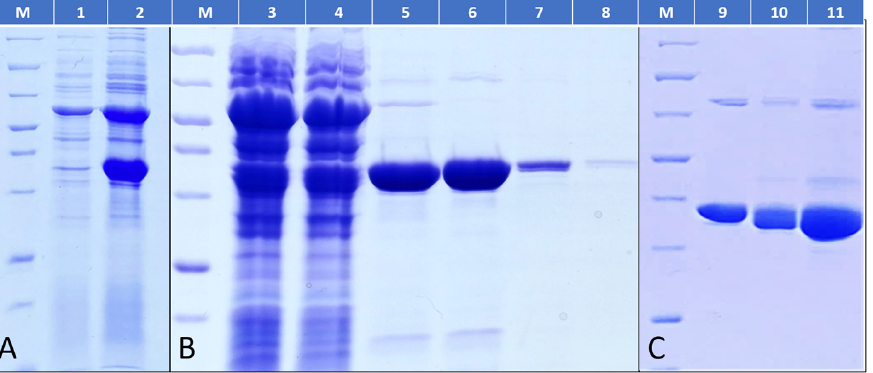
Figure 1. Purification of Tm -MreB using BL21 DE3 Arctic express cell line. ( A ) Molecular weight marker (M) followed by the cell lysates before (lane 1) and after induction with IPTG (lane 2). ( B ) Purification of Tm -MreB using high-salt purification buffers: lane 3: cell lysate before ultracentrifugation; lane 4: supernatant after ultracentrifugation; lanes 5–8: elution of protein with increasing imidazole concentration. ( C ) Last steps of the Tm -MreB purification: lane 9: Tm -MreB fraction before His-tag removal; lane 10: His-tag cleaved Tm -MreB; lane 11: concentrated, His-tag-free Tm